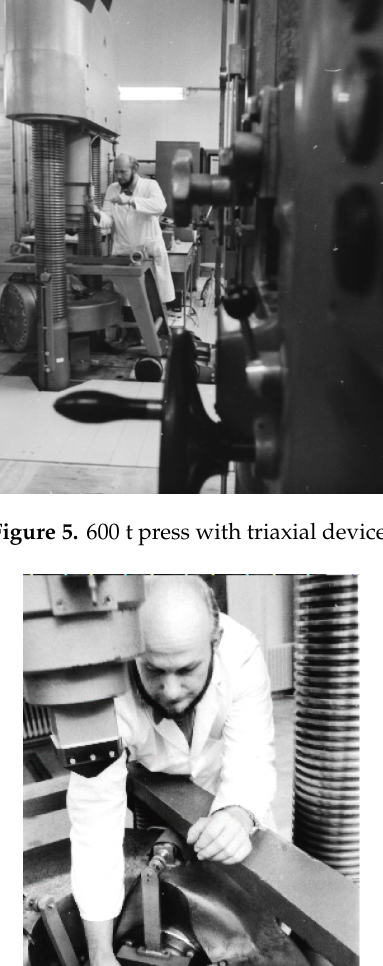
Figure 6. Sample insertion at the triaxial press.